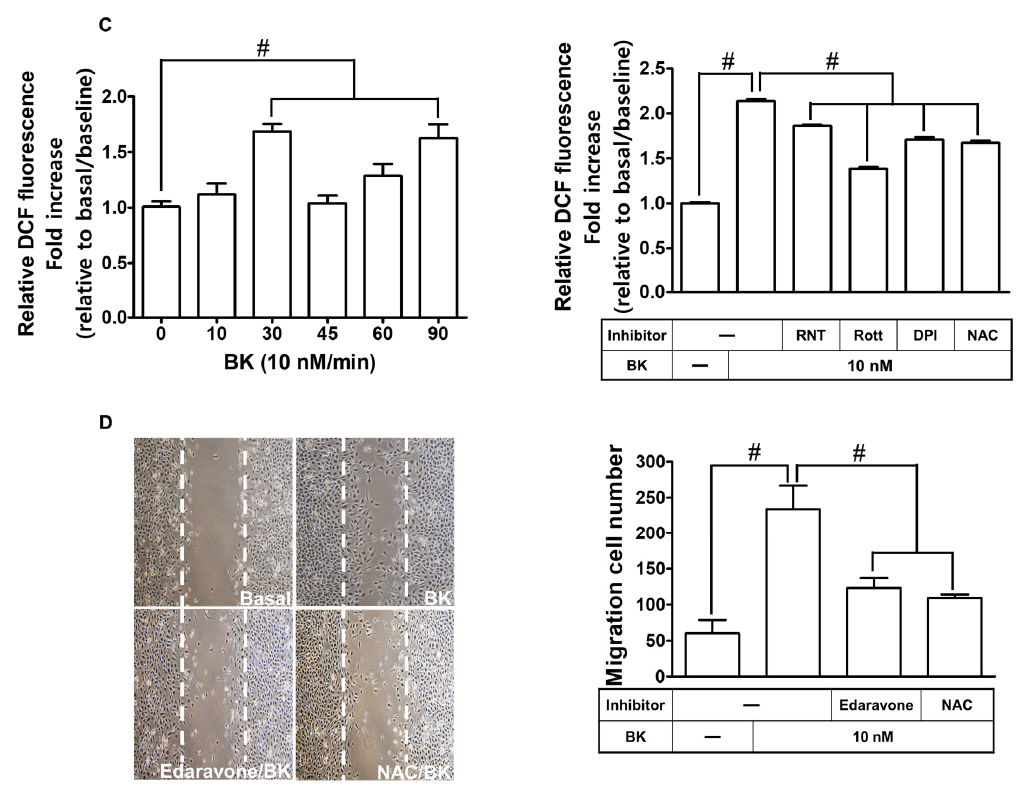
Figure 4. RNT mitigates reactive oxygen species (ROS) generation to block BK-induced MMP-9 expression and cell migra- tion in RBA-1 cells. ( A ) Cells were pretreated with 30 μ M edaravone, 1 mM N-acetylcysteine (NAC), or 10 μ M RNT for 1 h and then stimulated with BK (10 nM) for 16 and 24 h. The levels of MMP-9 in the media and GAPDH in cell lysates were examined by gelatin zymography and Western blot, respectively. ( B ) Cells were pretreated with 30 μ M edaravone or 1 mM NAC for 1 h and then incubated with BK (10 nM) of 6 h for analyzing MMP-9 mRNA expression and promoter activity, respectively, determined by real-time PCR and promoter assay. ( C ) Cells were incubated with BK (10 nM) for the indicated time intervals (10, 30, 45, 60, and 90 min; left panel), and cells were pretreated without or with 3 μ M rottlerin, 10 μ M DPI, 1 mM NAC, or 10 μ M RNT for 1 h and then incubated with 10 nM BK for 30 min (right panel). The fluorescence intensity of DCFH-DA staining was detected using a fluorescence microplate reader ( D ) Cells were pretreated without or with 30 μ M edaravone or 1 mM NAC for 1 h and then incubated with BK (10 nM) for 48 h. The number of cell migration was determined (magnification = 40×). Data are expressed as mean ± SEM of three independent experiments. # p < 0.01 as compared with the cells exposed to vehicle or BK, as indicated. Abbreviations: NAC, N-acetylcysteine; ROS, reactive ox- ygen